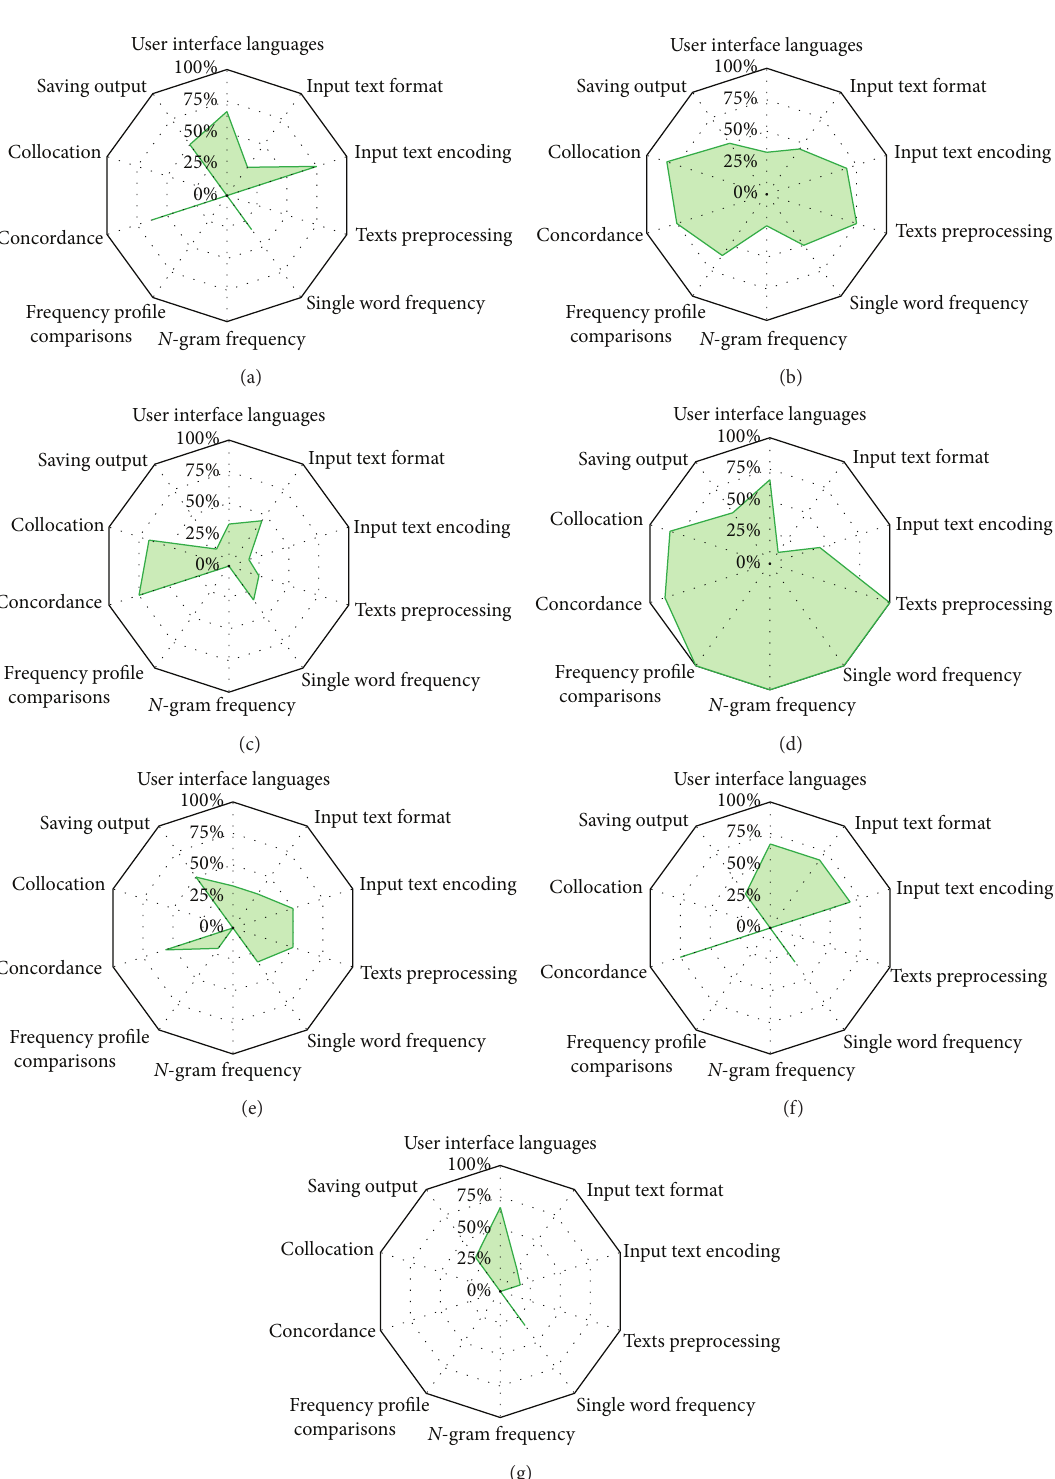
Figure2:(a)FunctionalityevaluationresultsforaConCordeV0.4.3.(b)FunctionalityevaluationresultsforAntConcV3.2.4.(c)Functionality evaluation results for KWIC V5.0. (d) Functionality evaluation results for Khawas V3.0. (e) Functionality evaluation results for SCP V4.0.9. (f) Functionality evaluation results for TextSTAT V2.9. (g) Functionality evaluation results for TextStat